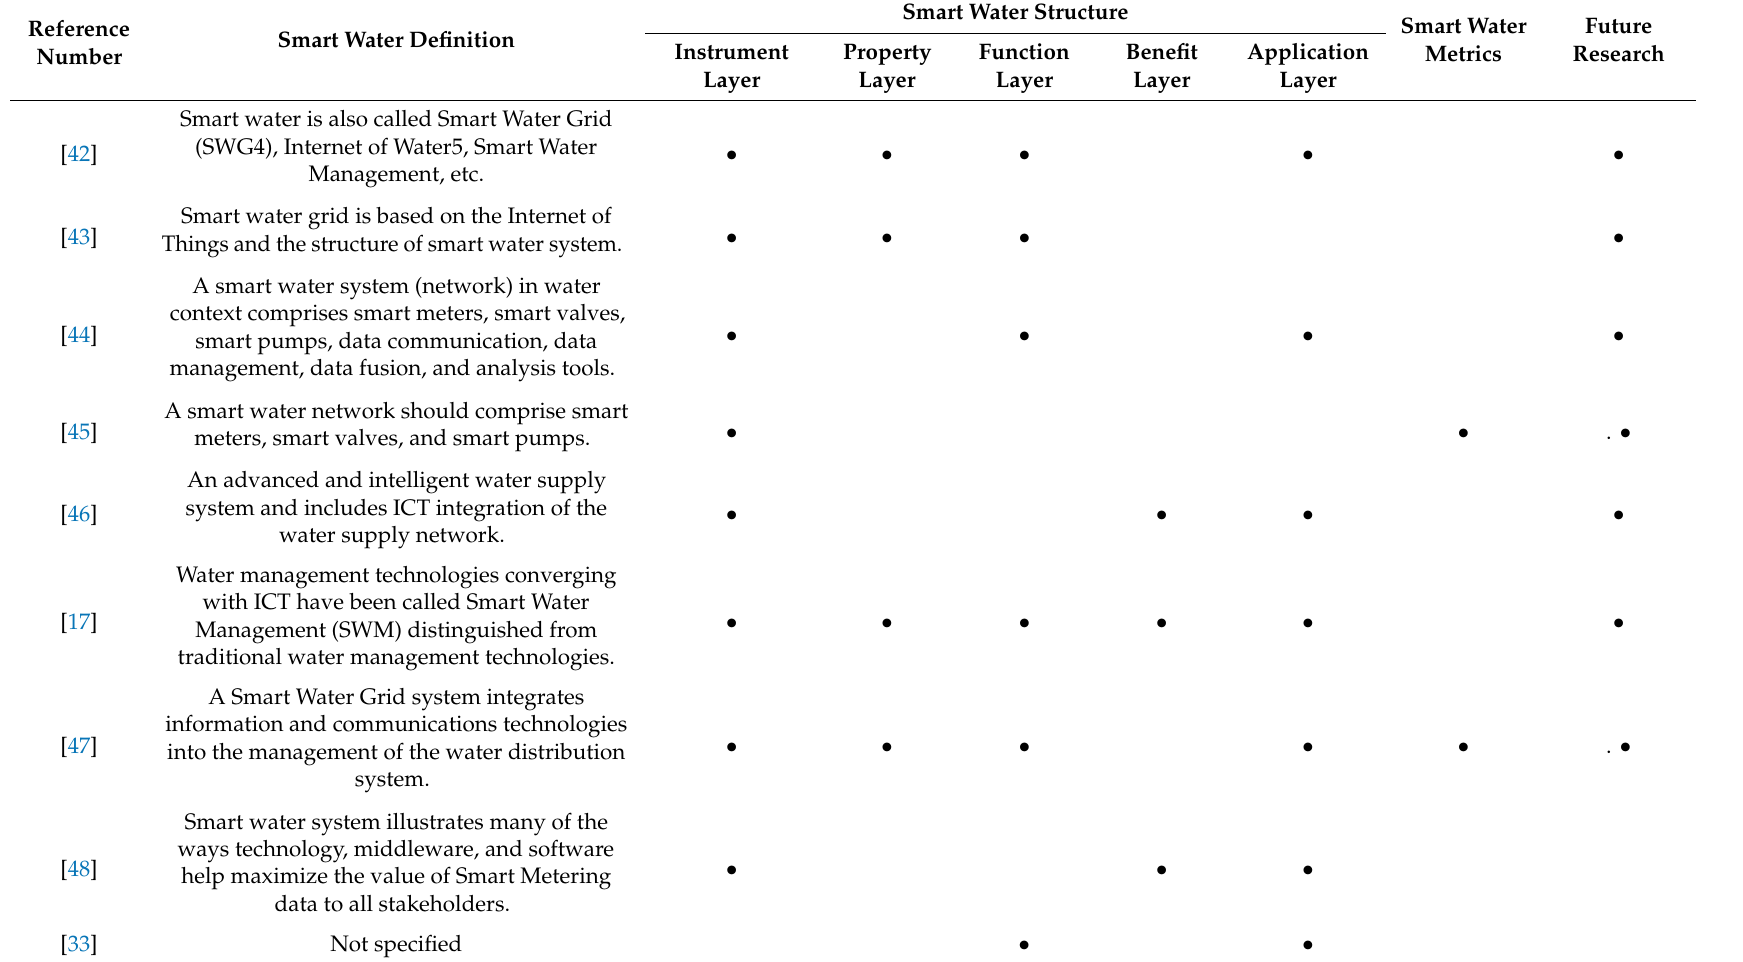
Table 1. Classification of the literature considering the framework in